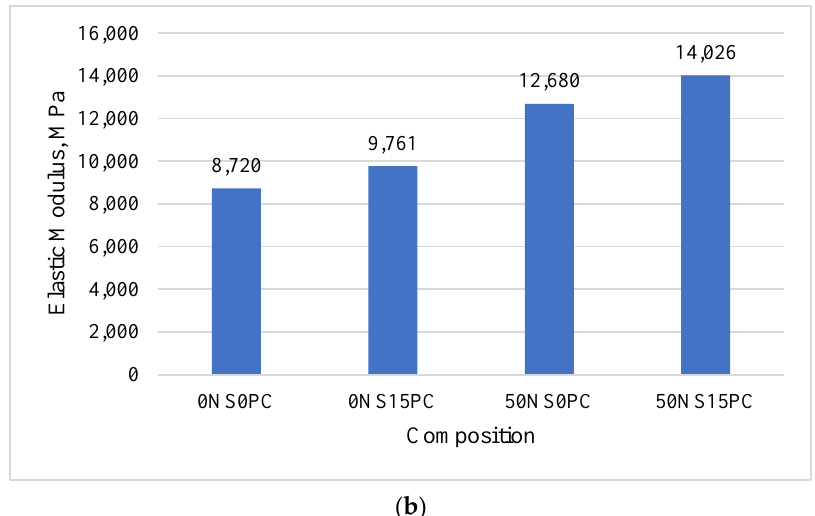
Figure 3. Concrete compressive strength development of concrete samples ( a ) and static elastic modulus of alkali-activated mortar prisms ( b ).